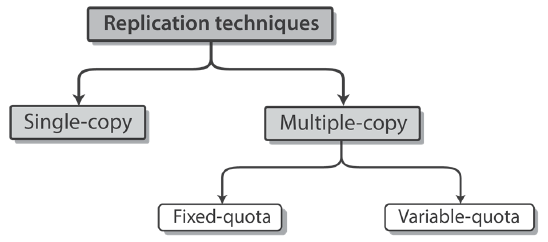
Figure 2. Taxonomy of message replication techniques in OppNets.